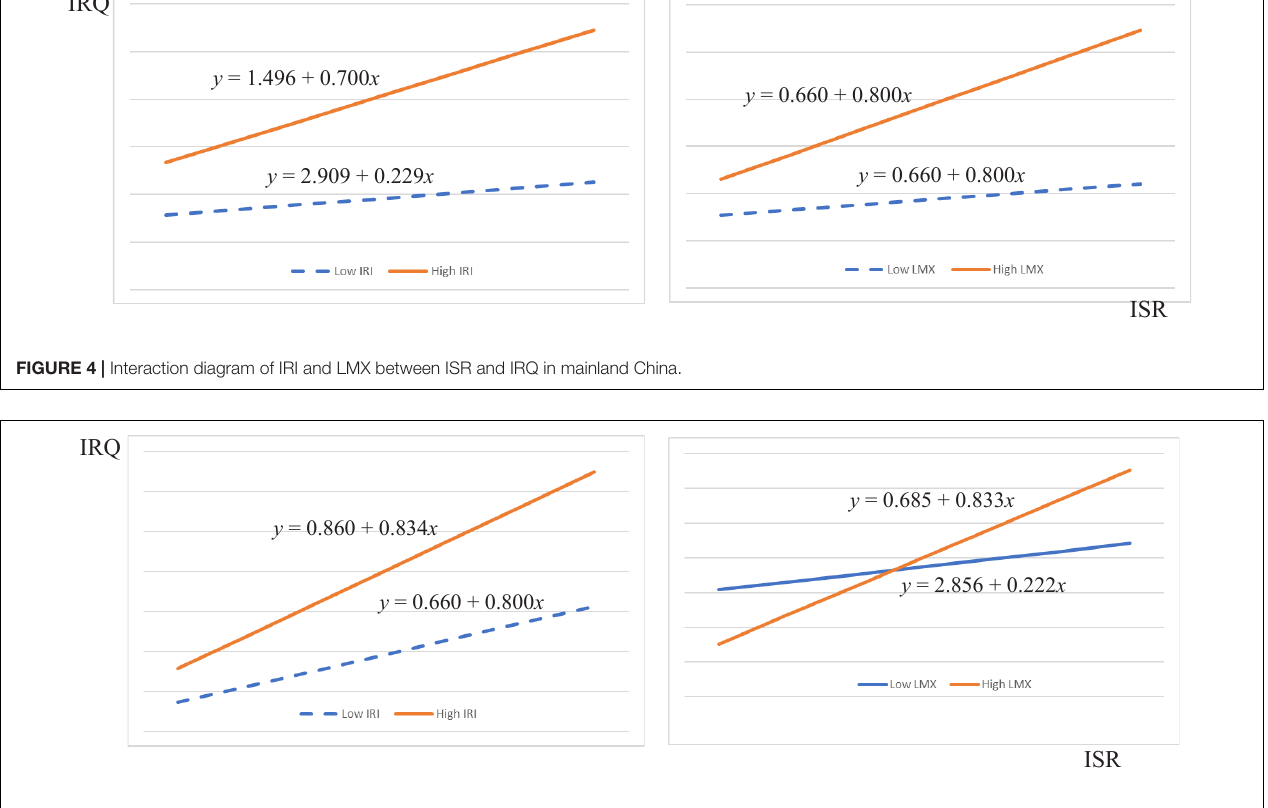
FIGURE 5 | Interaction diagram of IRI and LMX between ISR and IRQ in mainland